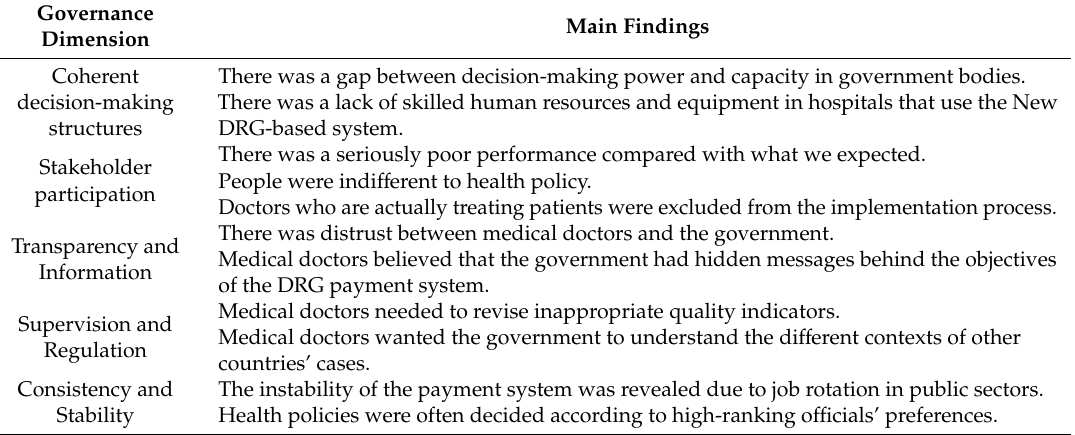
Table 2. Summary of the main findings by each governance